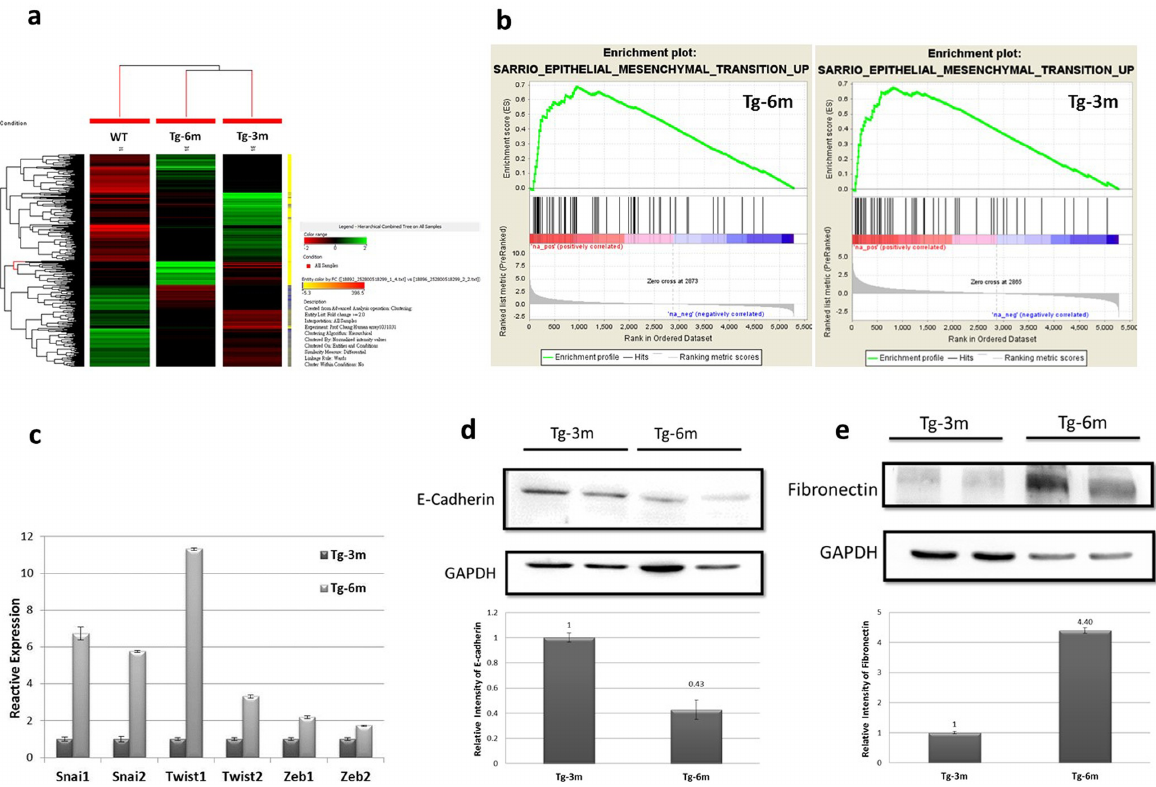
Fig 4. Six months (Tg-6m) mice displayed the epithelial-mesenchymal transition (EMT) phenomenon. (a) Hierarchical cluster analysisof normallung and lung tumors from Tg-3m and Tg-6m mice. (b) GSEA data showingenrichment of EMT signatures in both Tg- 6m and Tg-3m tumors. (c) Real-timeqPCR of key EMT regulators, Snail , Twist , and Zeb , indicatesthey were upregulatedin Tg-6m tumor cells. Data shown were representativeof 3 independentexperiment. (d, e) Western blot analysisof E-cadherinand fibronectin proteins in Tg-3m and Tg-6m tumor cells. The amount of the epithelial marker, E-cadherin, had decreased in Tg-6m cells comparedto Tg-3m cells (d). In contrast, the amount of the mesenchymal marker, fibronectin, had increasedin Tg-6m cells (e). Shown were representative blots of 3